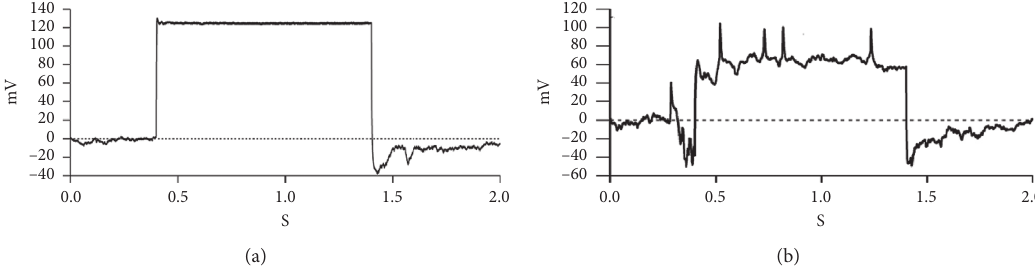
Figure 4: Whole cell membrane clamp recordings showing the electrophysiological behavior of the transfected group (b) presenting neuron waveform after 21 days of induction, compared to the control group